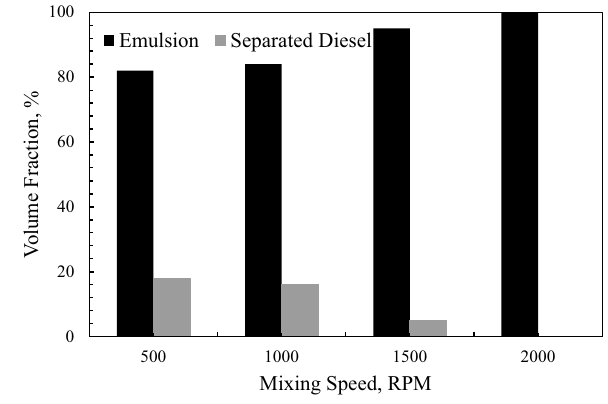
Fig. 1 Droplet size of the emulsified gels at different mixing speeds at (25 °C), as measured by LPSA Fig. 2 Effect of mixing speed on the droplet size after 1 week at 25 °C, as observed micro- scopically: a 500 rpm, b 1000 rpm, c 1500 rpm and d 2000